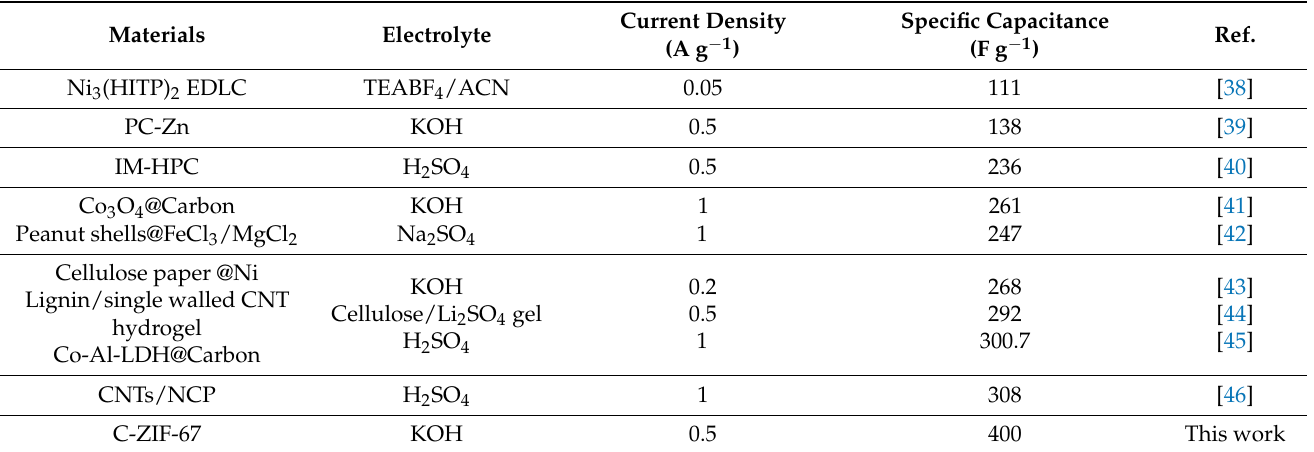
Figure 7. CV curves of C1-ZIF-67 ( a ) and C2-ZIF-67 ( c ) at different scan rates varying from 20 to 100 mV s − 1 , and charge–discharge curves of C1-ZIF-67 ( b ) and C2-ZIF-67 ( d ) at different current densities. Table 2. The specific capacitance of C-ZIF-67 and other materials.